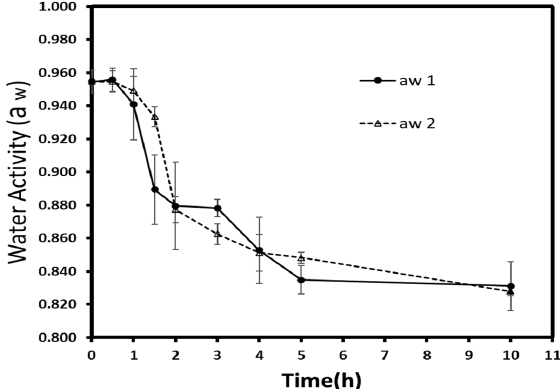
Figure 4. Water activity evolution during osmotic dehydration at atmospheric (a w 1) and vacuum (a w 2) pressures. Each point represents the mean and standard deviation of duplicate of three repetitions.